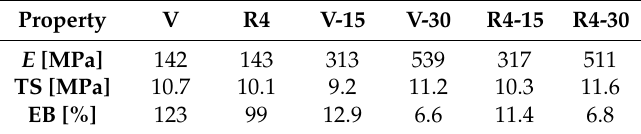
Table 3. Elastic modulus ( E ), tensile strength at break (TS), elongation at break (EB) for neat